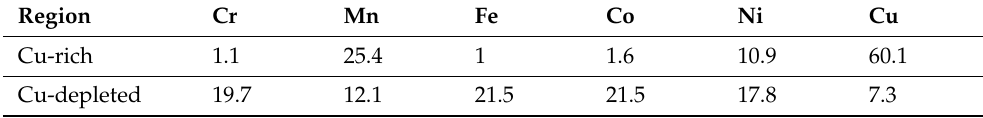
Table 3. Compositions of the Cu-rich and Cu-depleted regions after high-temperature heat